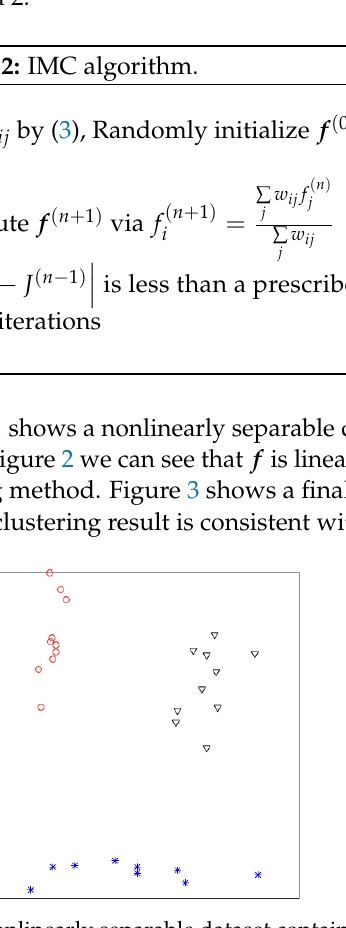
Figure 1. A nonlinearly separable dataset containing three clusters.